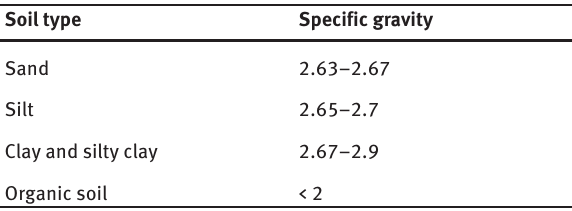
Table 4: Specific gravities ranges for various soil types (Das & Sawicki,